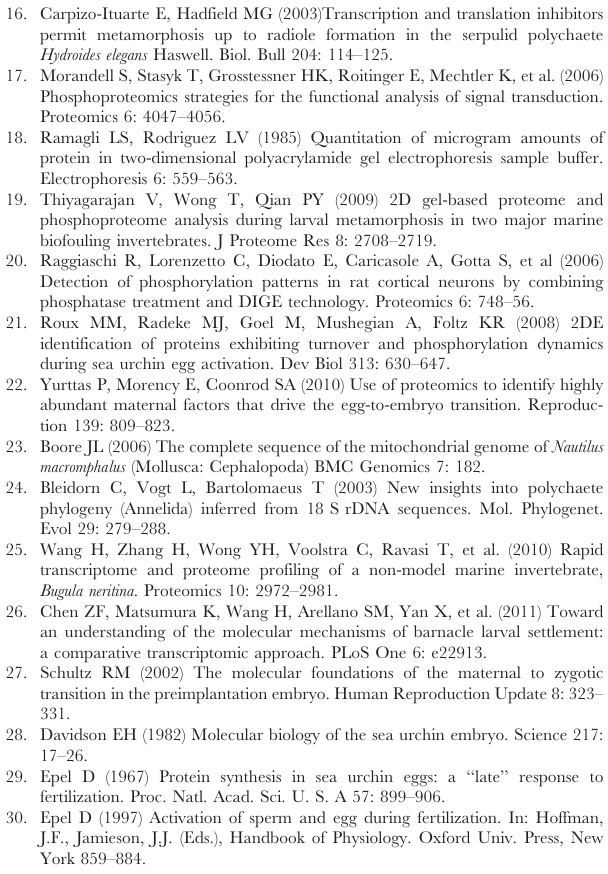
Figure S2 Representative tandem mass spectra of the phosphorylated peptide 625 YSGHSMSDPGTSYR 640 and 285 MLFTPPEDTSPAGGKK 298 . A: MS/MS spectrum of the peptide phosphorylated at Ser-291. B: MS/MS spectrum of the peptide phosphorylated at Thr- 628. The peptide fragment location within the protein is indicated by the NH2- and COOH-terminus of the residual phosphorylated peptide sequence. Table S1 Identification of abundant proteins during early development in Neanthes arenaceoentata by ESI- QTOF. a) Accession numbers are from Capitella sp I* genome database and in-house transcriptome sequences of H.elegans** and P.vexillosa . *** Significance threshold level for positive identification was p , 0.05. PM: number of peptides matched to protein sequence; SC: sequence